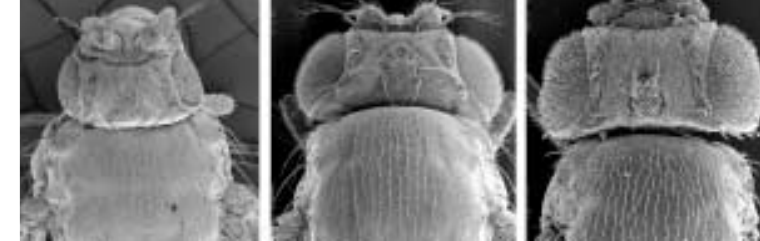
Mutations in the Drosophila gene chicoencoding the homologue of IRS1–4 cause a proportional reduction in body size. The two flies on the left are homozy- gous for chico. Their body size is reduced by 50% compared with the two het- erozygous flies on the right. The small size is caused by a reduction in the number and the size of the cells.